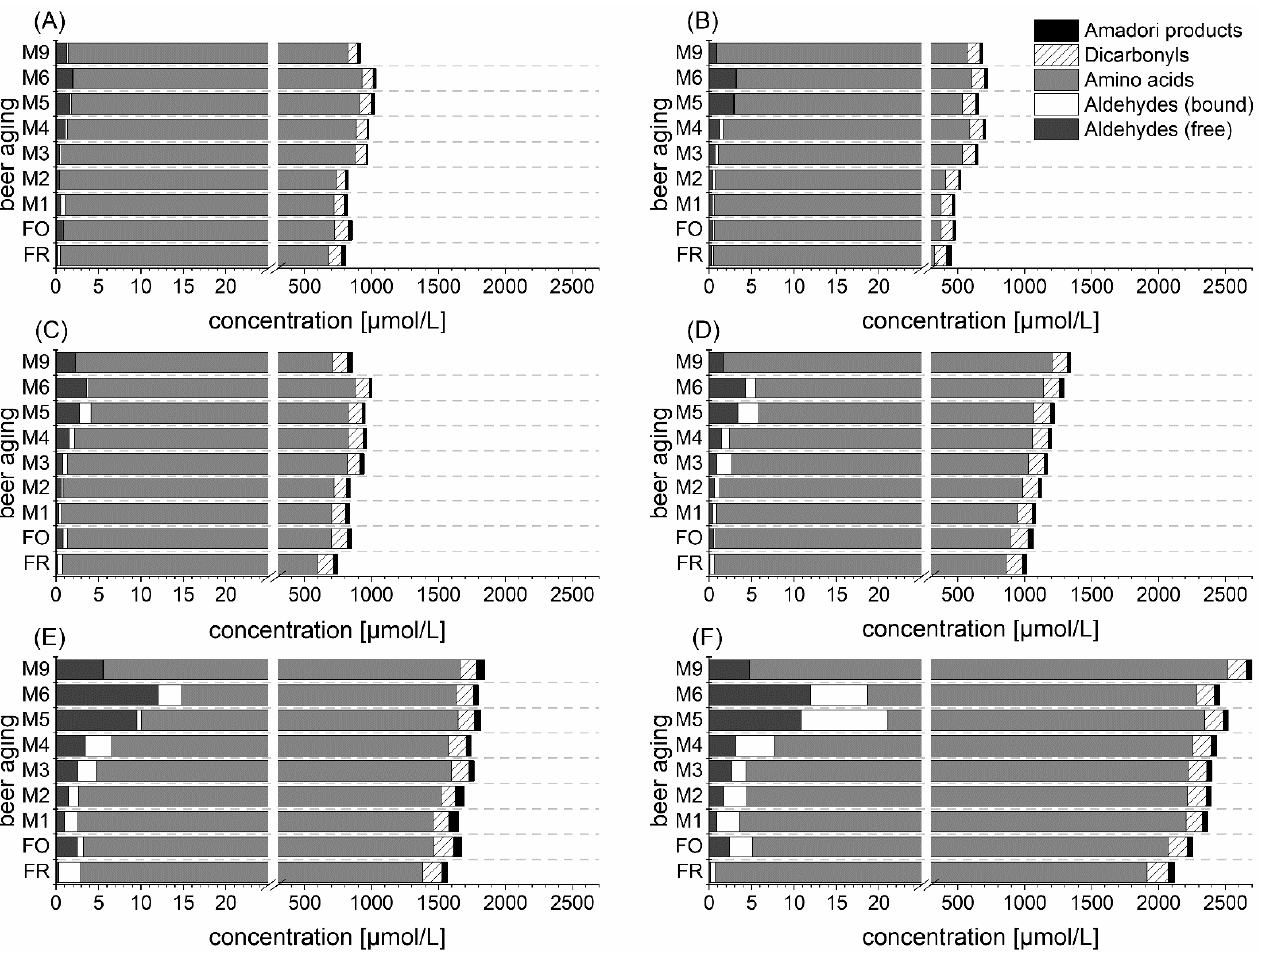
Figure 6. Molar distribution of free and bound aldehydes and precursor compounds (amino acids, dicarbonyls, Amadori products) during aging in beer at three different malt modification levels (P1 < P2 < P3) and two barley varieties (B1 and B2); ( A) B1P1; ( B ) B2P1; ( C ) B1P2; ( D ) B2P2; ( E ) B1P3; ( F ) B2P3.